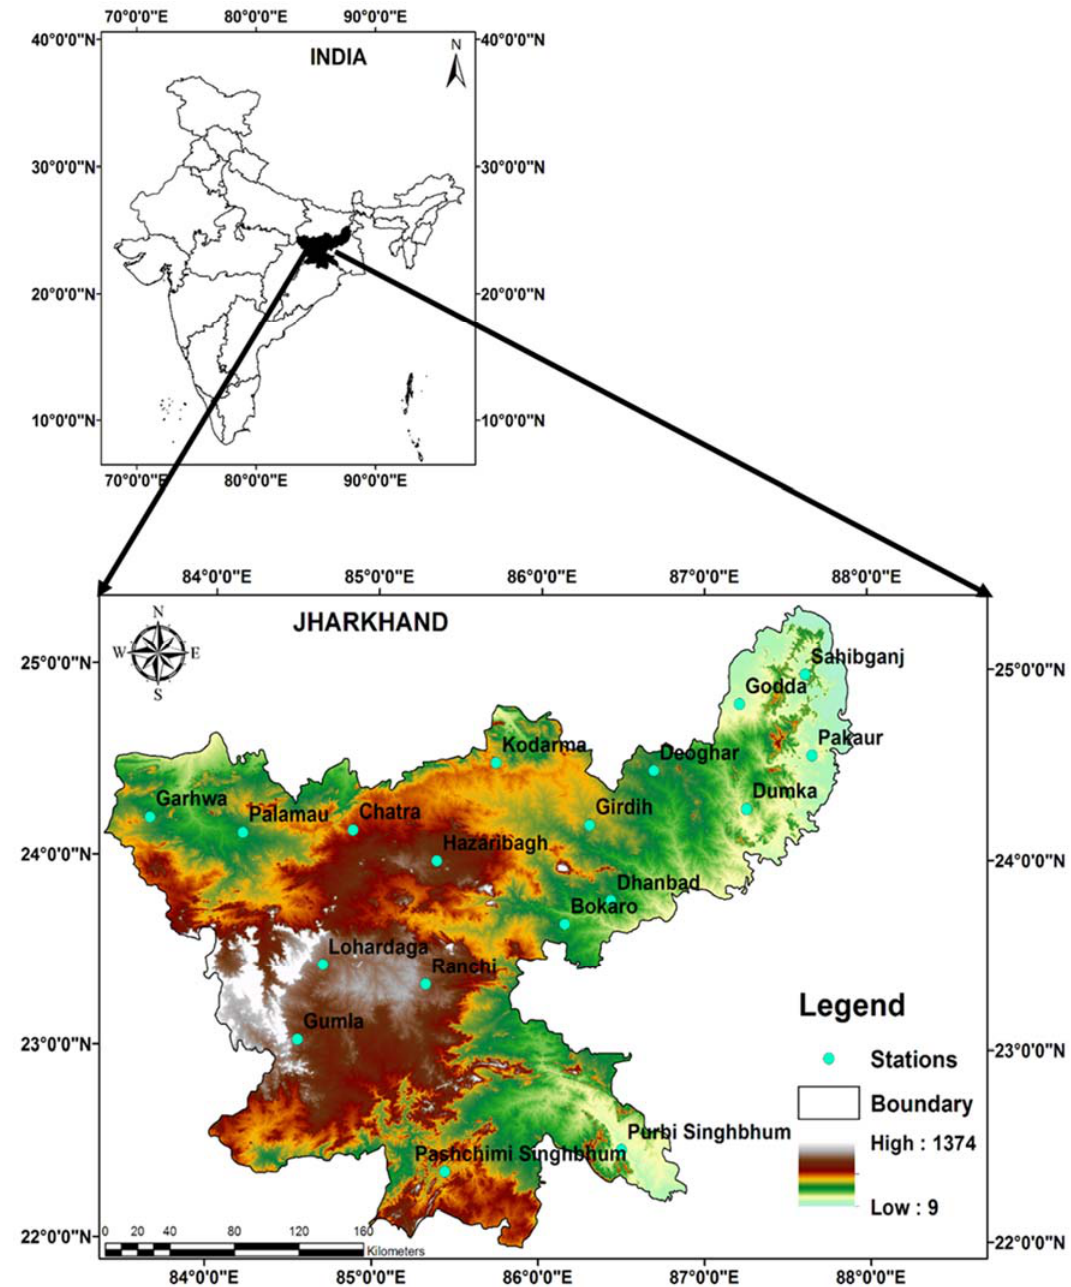
Figure 1. Jharkhand study area showing rain gauge stations along with elevation (in meters).